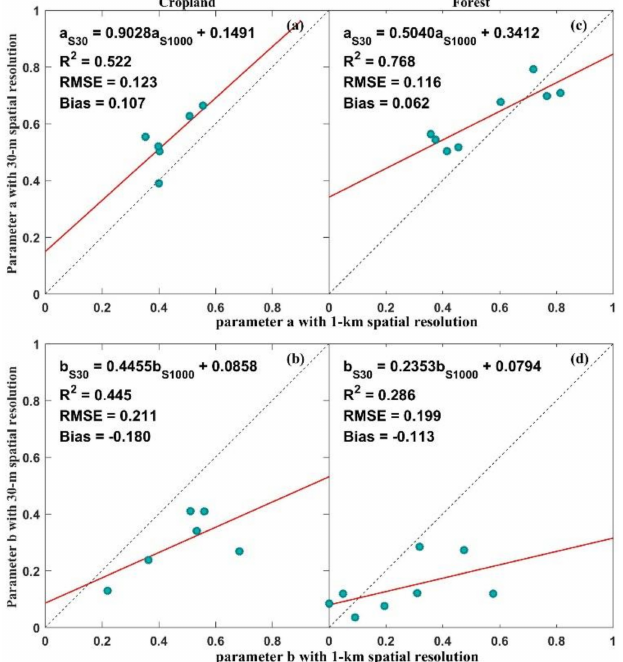
Figure 5. Scaling equations of model parameters (SEMPs); ( a ) SEMP a of the cropland sites; ( b ) SEMP b of the cropland sites; ( c ) SEMP a of the forest sites; ( d ) SEMP b of the forest